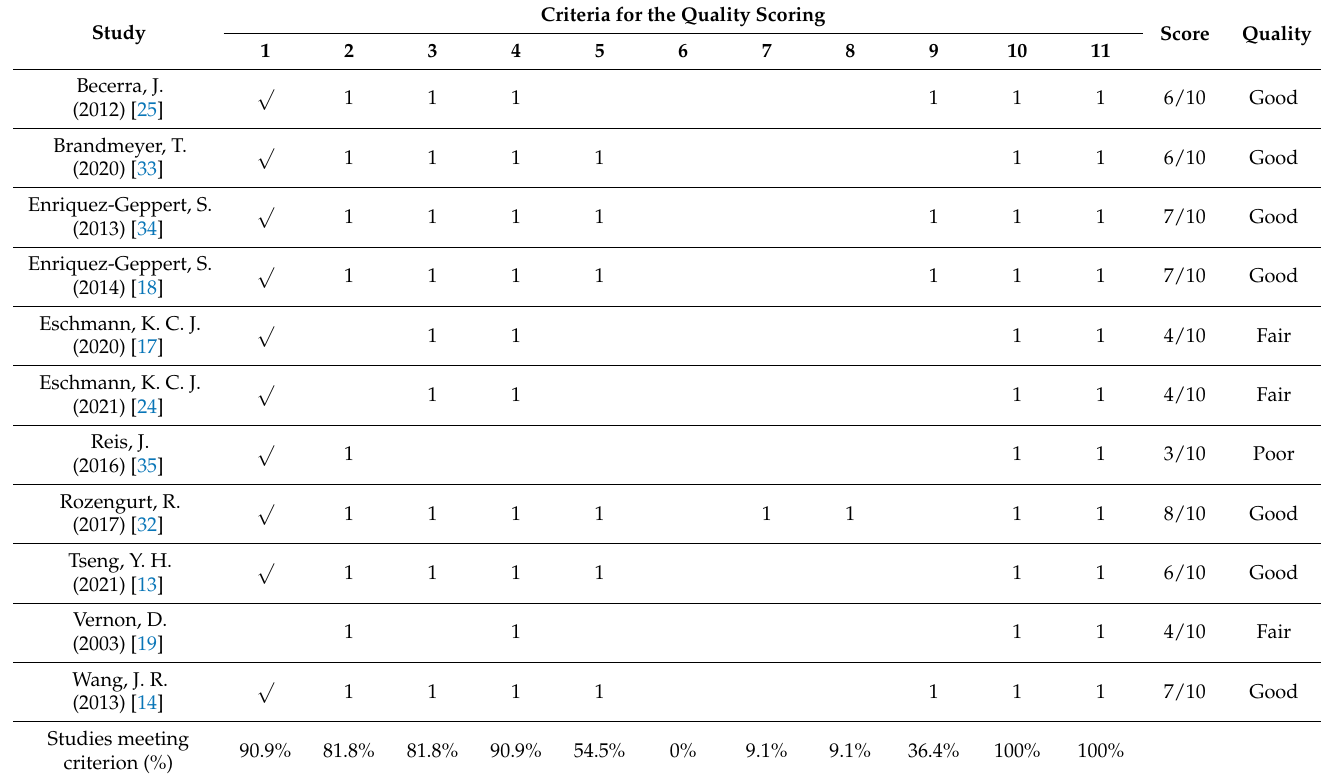
Table 2. Quality assessment of the studies included according to the PEDro scale.